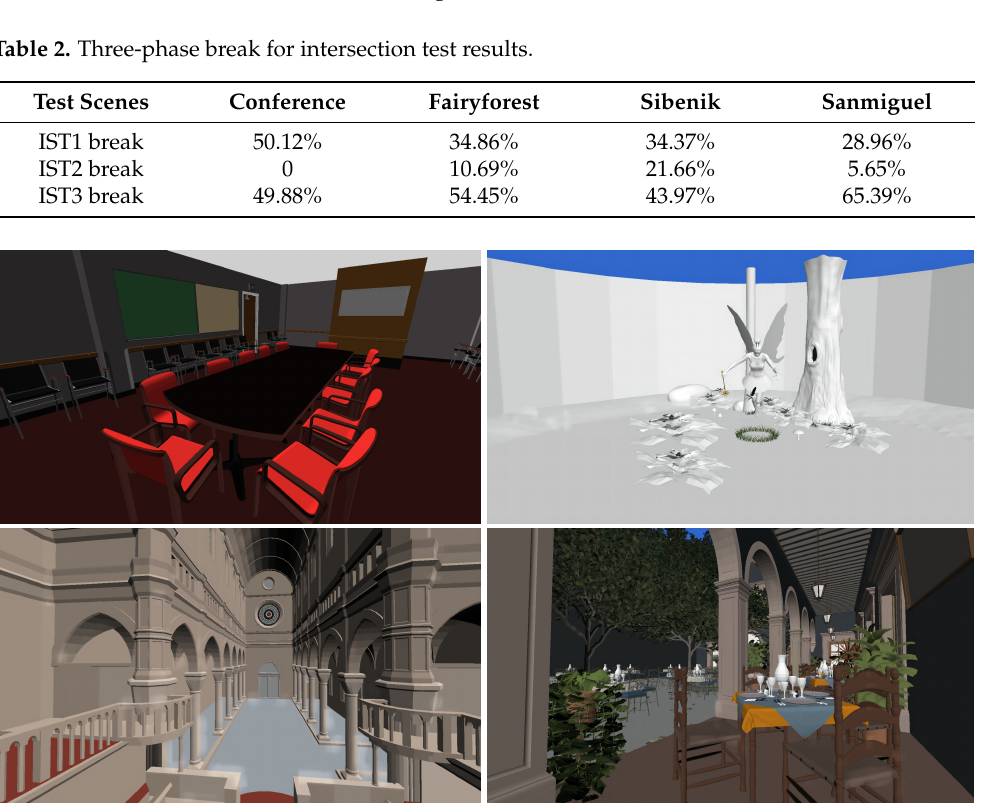
Figure 4. Test scenes: Conference, Fairyforest, Sibenik and Sanmiguel with primary